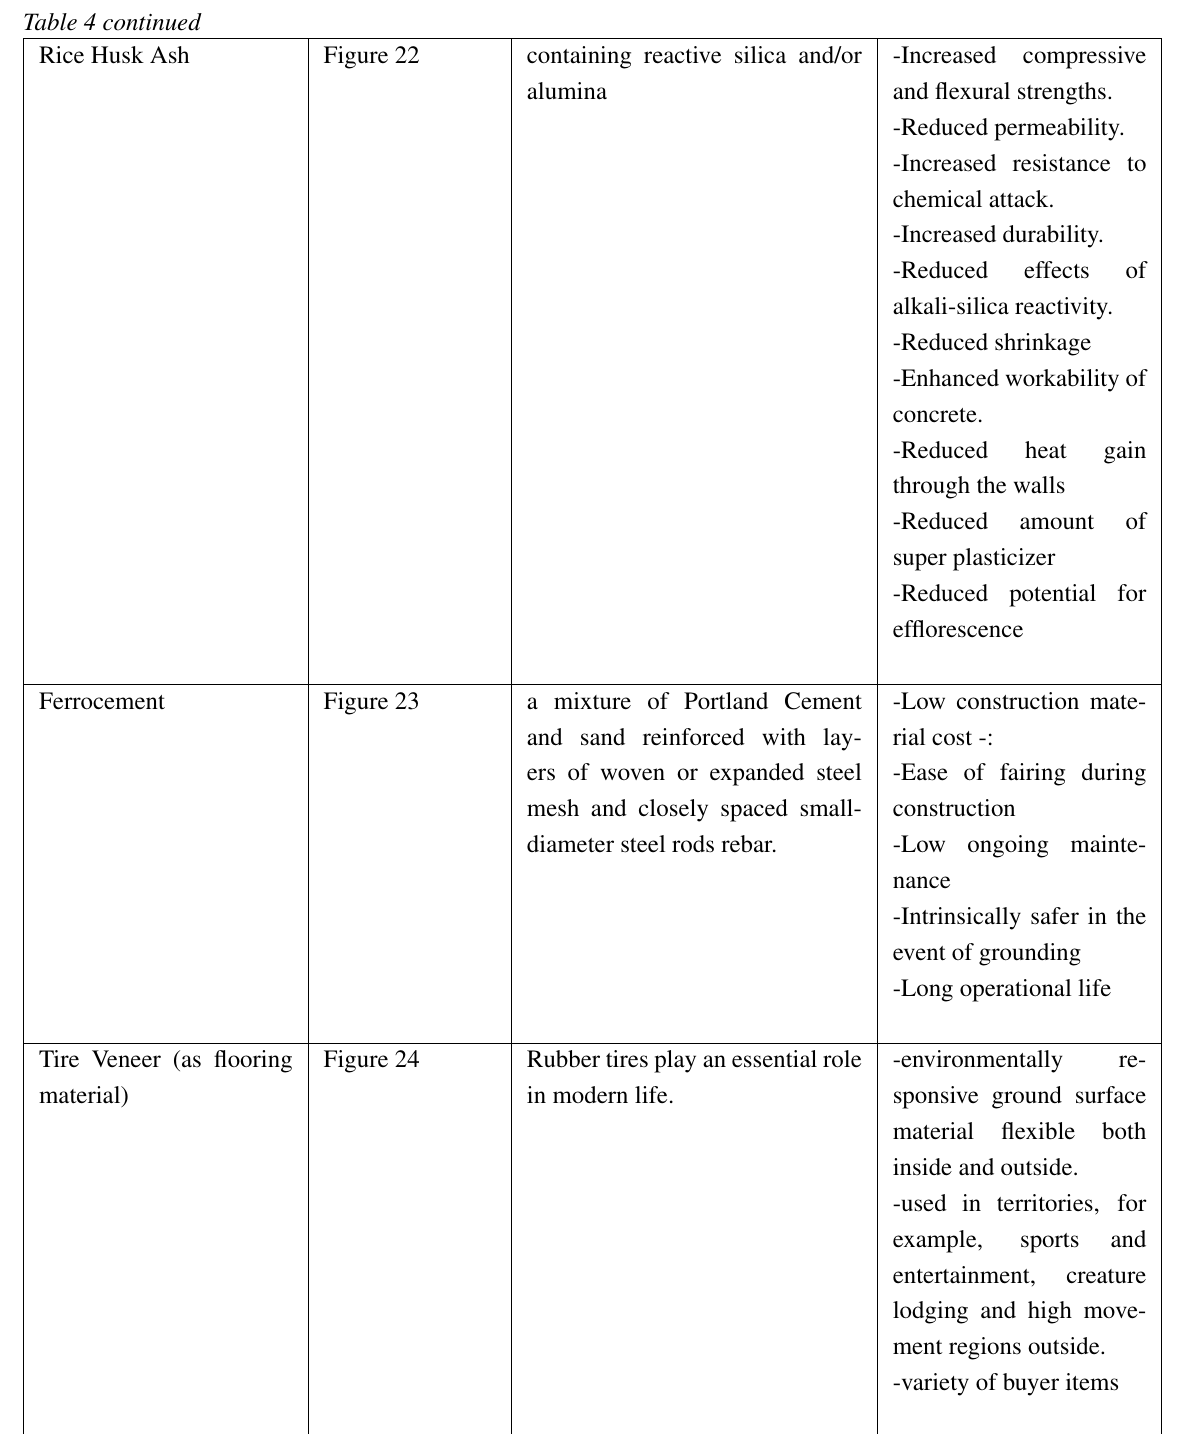
Figure 24 Rubber tires play an essential role in modern